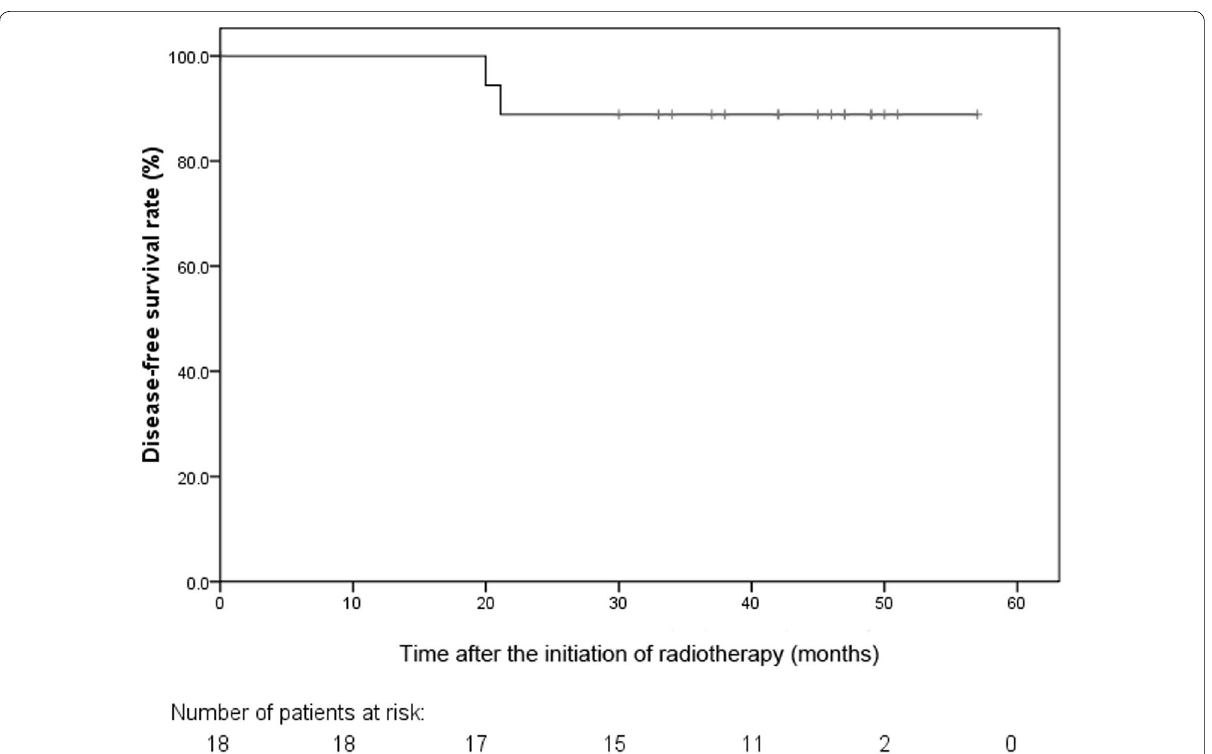
Fig. 3 Disease‑free survival (DFS) curve of the 18 patients with ypM0 (pathologic M0) sigmoid colon cancer. DFS was calculated by using Life Table methods. The cumulative probability for 3‑year DFS rate was